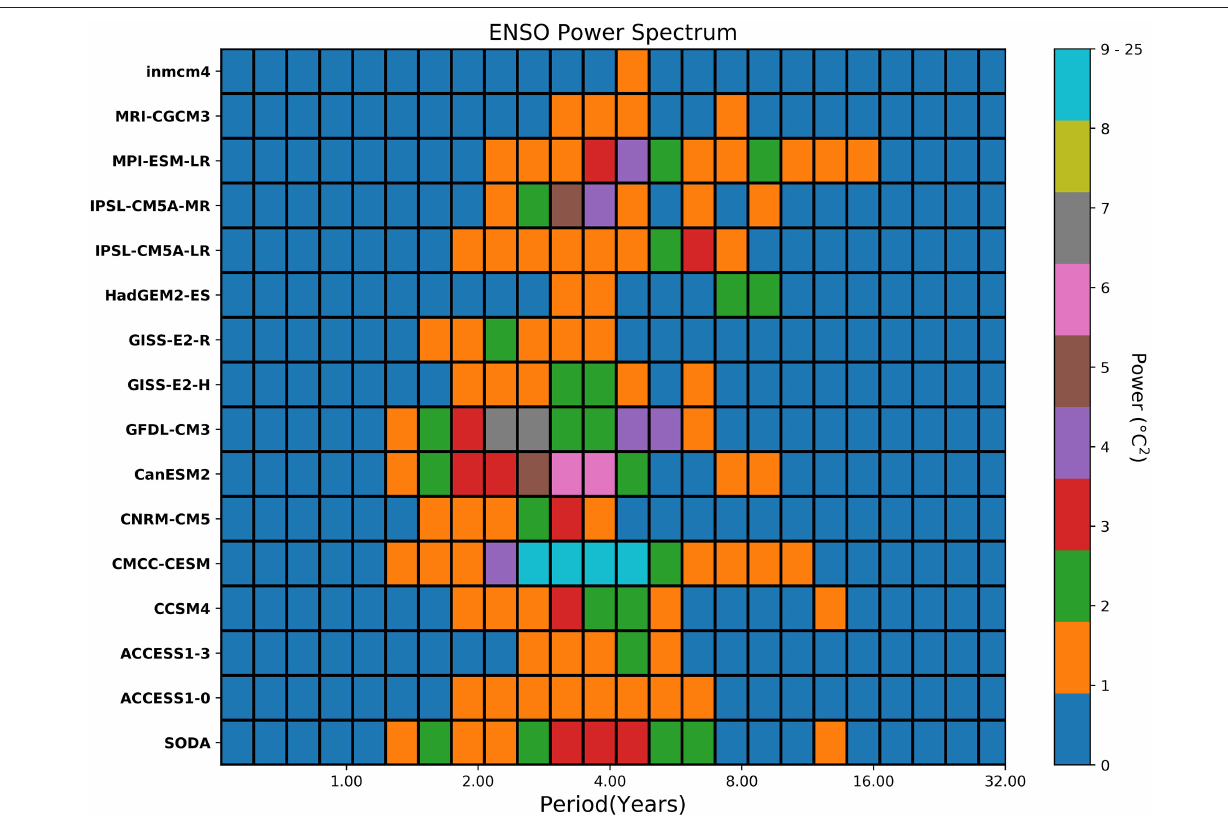
between the Z20 anomalies and Niño-3.4 reached − 0.62 over the period